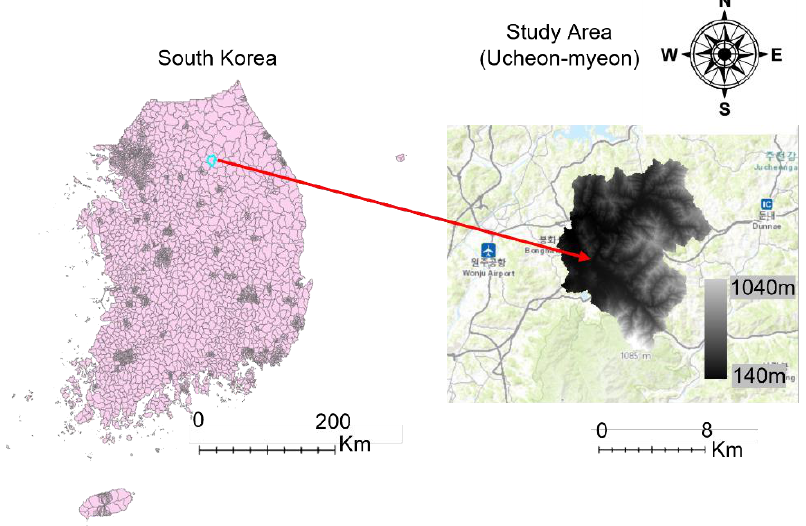
Figure 2. Case study area: Ucheon-myeon district in South Korea.